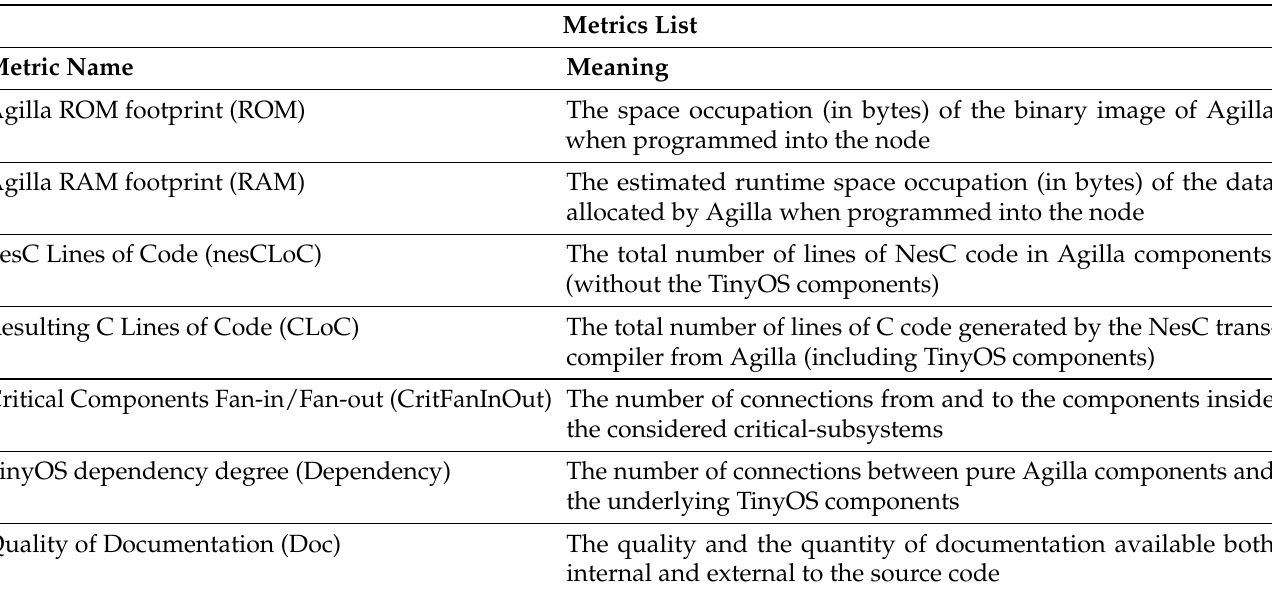
Table 4. Adopted metrics for the evaluation of porting